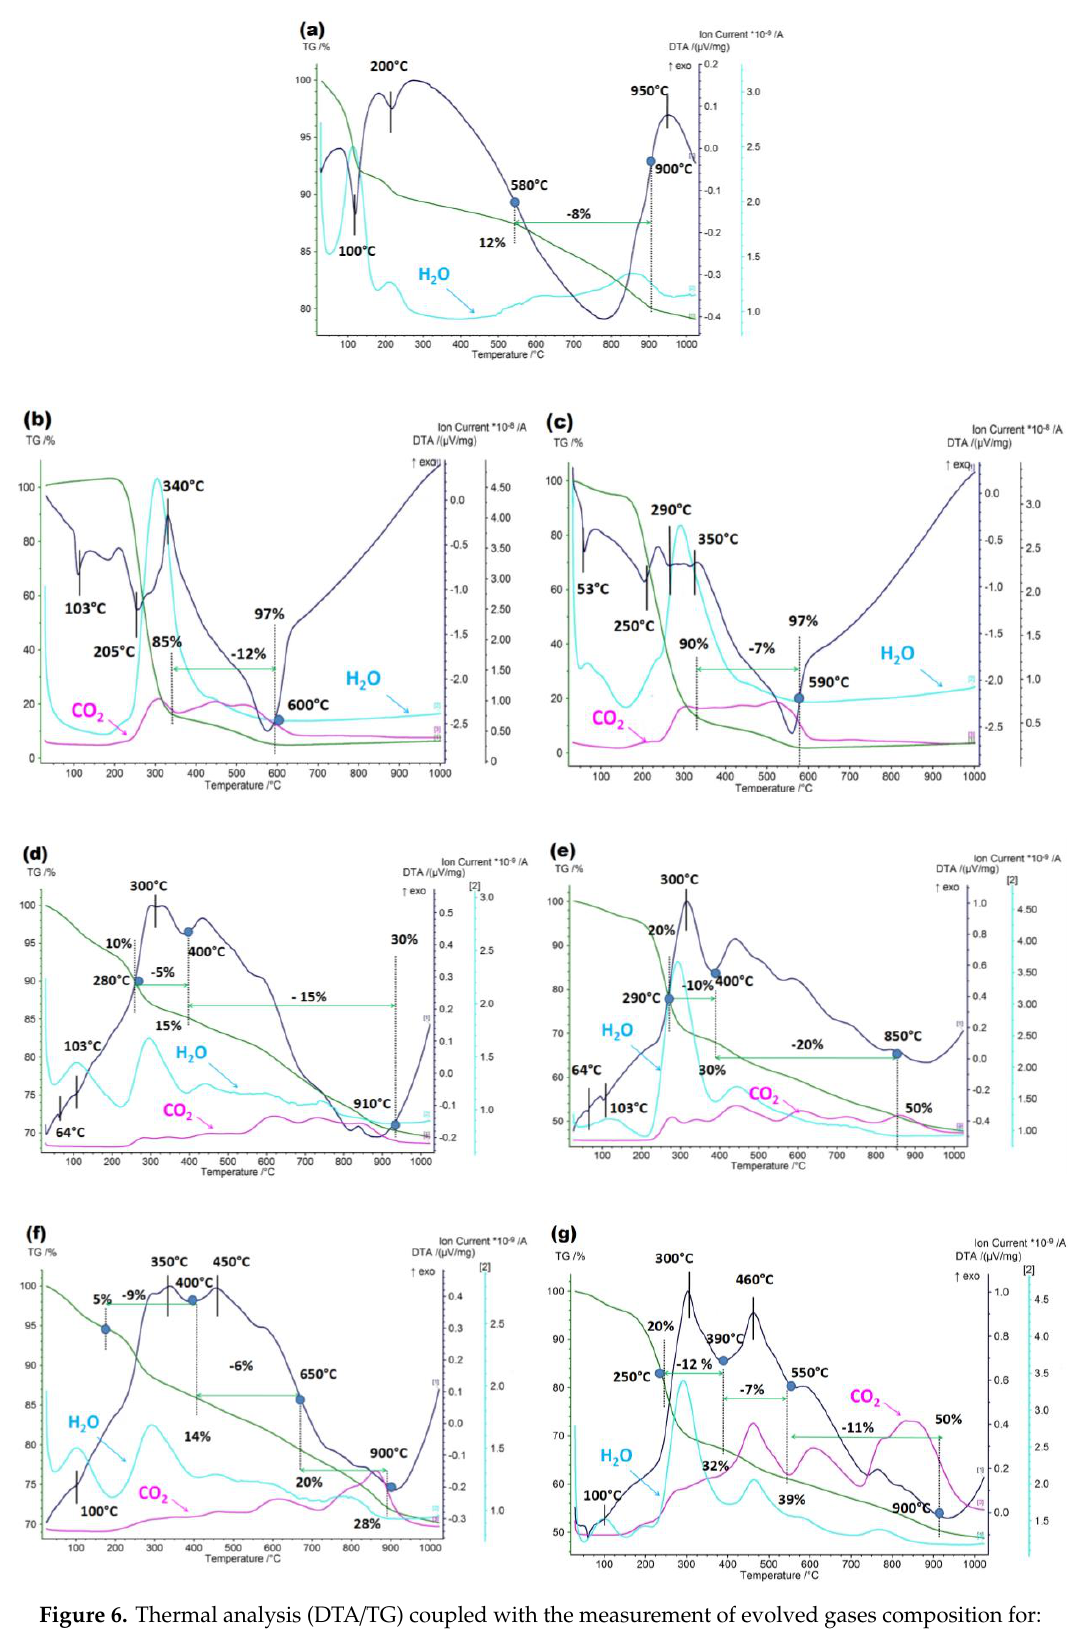
Figure 6. Thermal analysis (DTA / TG) coupled with the measurement of evolved gases composition for: ( a ) VER, ( b ) HDTMA, ( c ) HDBA, ( d ) 0.5 HDTMA, ( e ) 2.0 HDTMA, ( f ) 0.5 HDBA, and ( g ) 2.0